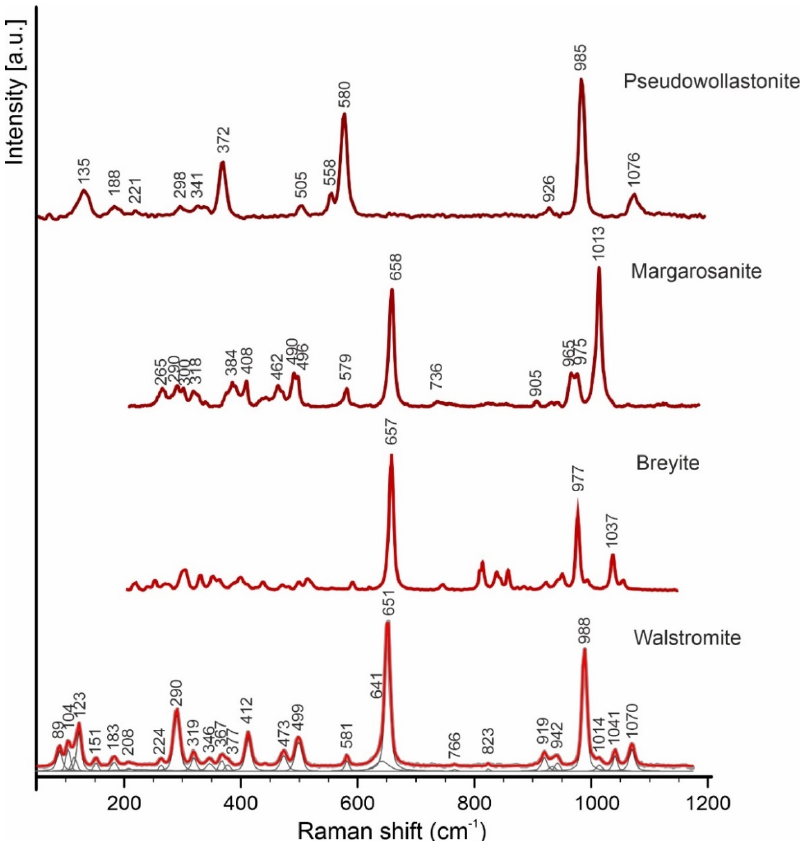
Figure 4. Raman spectra of walstromite from paralava of the Gurim Anticline and breyite (Anzolini et al., 2018 [16], excitation line 532 nm), margarosanite from Parker shaft, Franklin, NJ, USA (RRUFF, 532 nm) and pseudowollastonite-2M from gehlenite hornfels of the Negev Desert (488